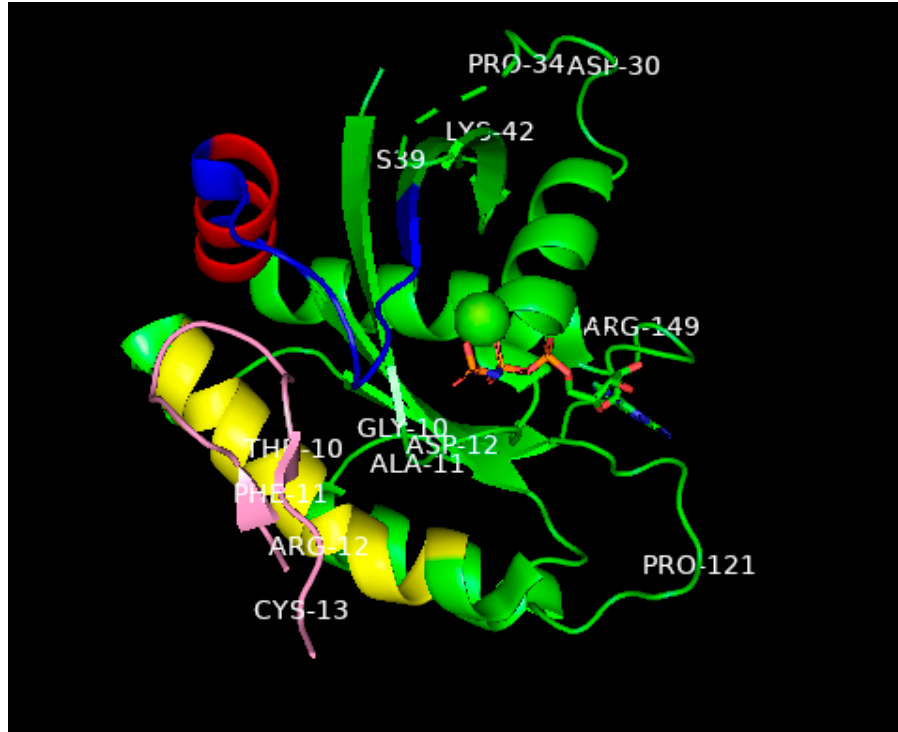
Figure 5. Ribbon representation of the X-ray structure (ref. [29], PDB entry 6WGN) of KD2 bound to G12D-RAS-p21-GppNHp rotated to show the location of KD2 (pink) in the groove in the switch 2 domain (residues 55–76) which is colored blue except for the α 2 helix involving residues 67–73, colored red. This helix is rotated by 90 ◦ relative to its position in wild-type RAS-p21. The yellow-colored segment is the α 3 helix involving residues 89–103. A significant segment of the pink KD2 peptide is seen to bind in a deep groove between the α 2 helix and a significant part of the switch 2 domain shown as the blue strand to the right and above the pink segment. GppNHp is seen in the middle, right of the figure with the guanine ring on the far right; the β - and Υ -phosphates (the phosphates are colored orange) are seen to bind to the magnesium ion shown as a green sphere in the center of the figure. The oncogenic Asp 12 residue is shown in the middle of the P loop domain, some of whose other residues (Gly 10 and Ala 11) are also shown. Additionally, to be noted: The all-important switch 1 domain containing residues 32–47 that contacts the RBD of RAF is shown in the upper right of the figure. Some of the residues in this domain such as Pro 34, Ser 39 and Lys 42 are shown to help identify this domain. Between Pro 34 and Ser 39, there is a series of green dashes denoting the absence of location of the atoms in the intervening segment, this is due to the disordered switch 1 domain in state 1 (inactive) in GTP-bound RAS-p21. See text for explanation.